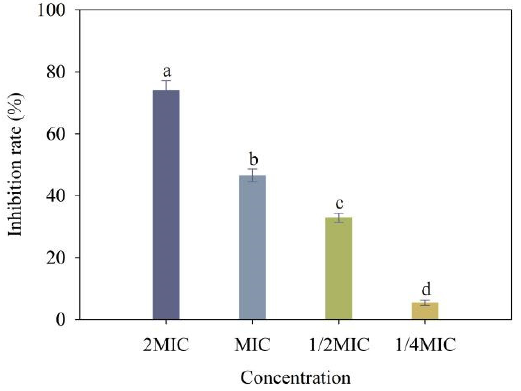
Figure 9. Effect of different concentrations of 4-allylbenzene-1,2-diol on EPS production of Xoo. Note: Different lowercase letters show the significant difference at p < 0.05 level using Duncan’s new multiple range test, respectively.